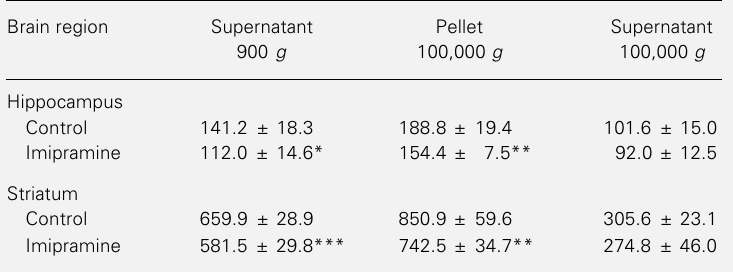
Table 1 - Achase activity in the hippocampus and striatum of rats chronically treated with imipramine. Achase activity is reported as nmol thiocholine formed min -1 mg protein -1 . Results are reported as mean – SD for 6 animals in each group. Final acetylthiocholine concentra- tion in the assay was 1 mM. *P<0.02, **P<0.005, ***P<0.001 compared to control (Student t